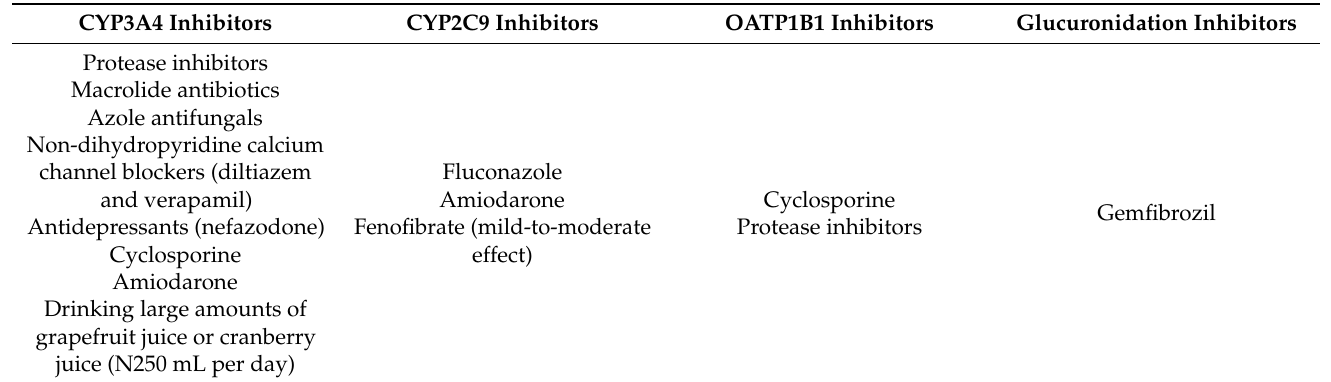
Table 1. Drugs potentially interacting with statins to increase myopathy